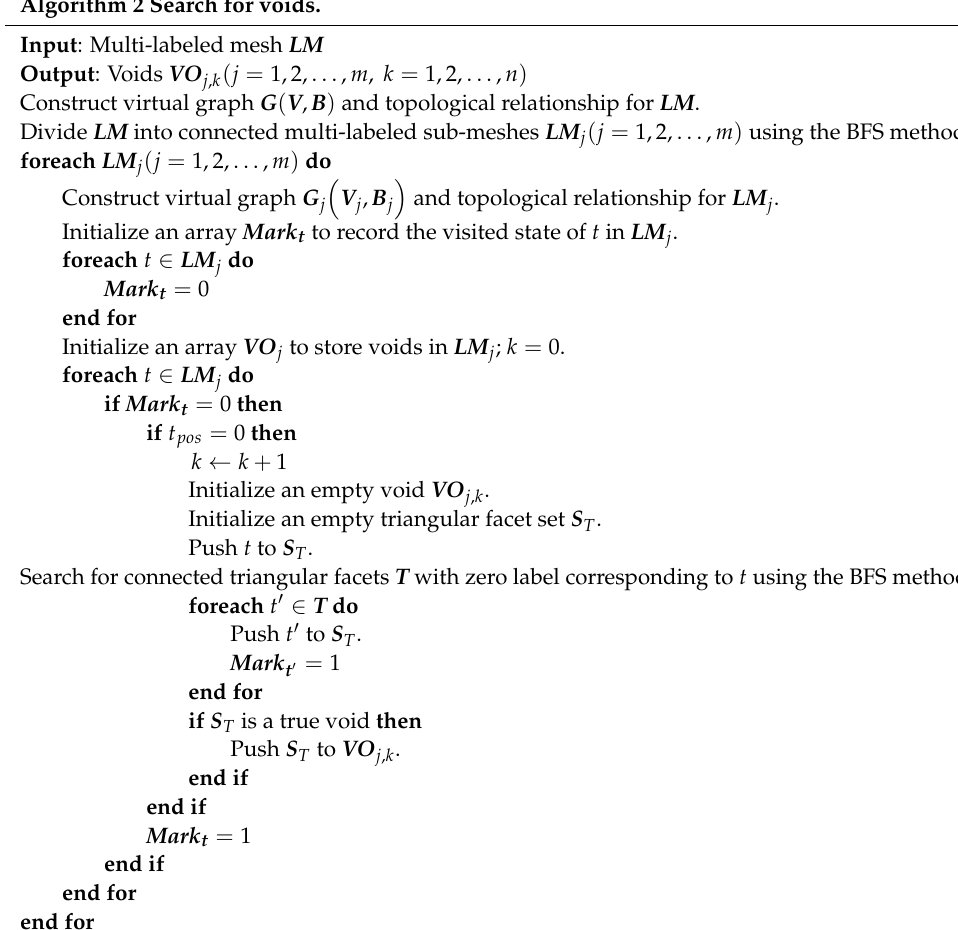
Algorithm 2 Search for